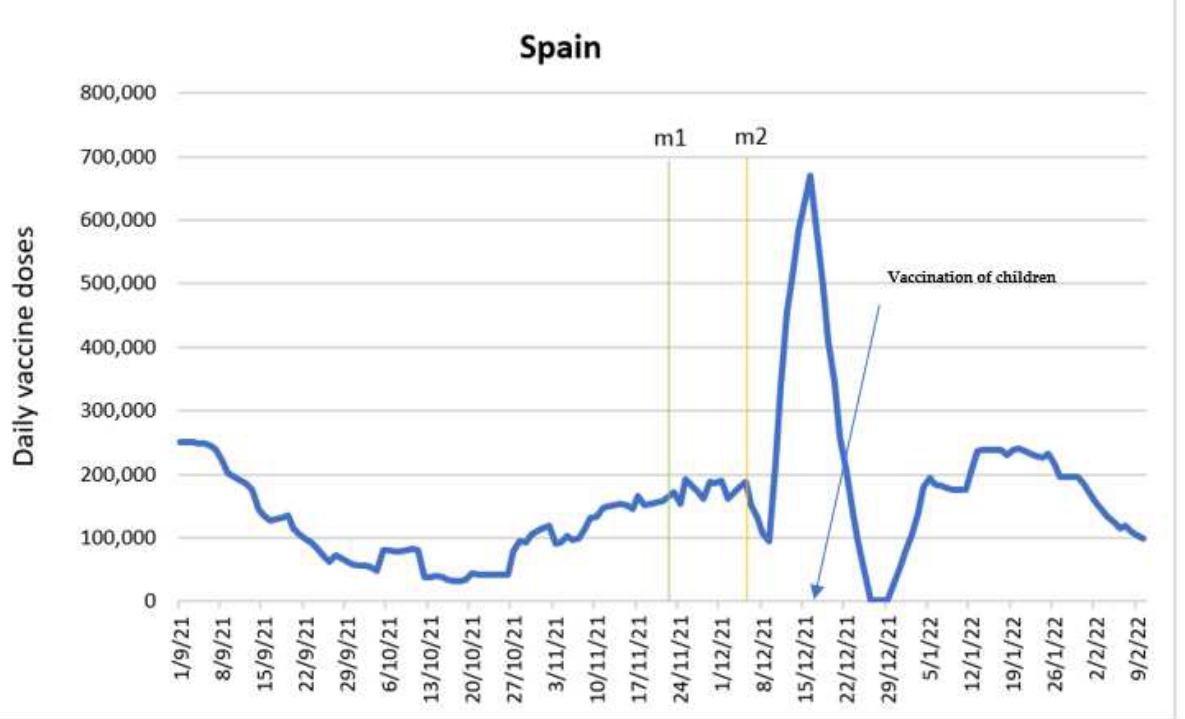
Figure 7. Daily new vaccinations in Spain before and after the introduction of COVID certificates. Figure 1. Daily new vaccinations in Austria before and after the policy changes and predicted values in absence of intervention based on ARIMA model. Announcement of the introduction of COVID certificates (m1) COVID certificates in force